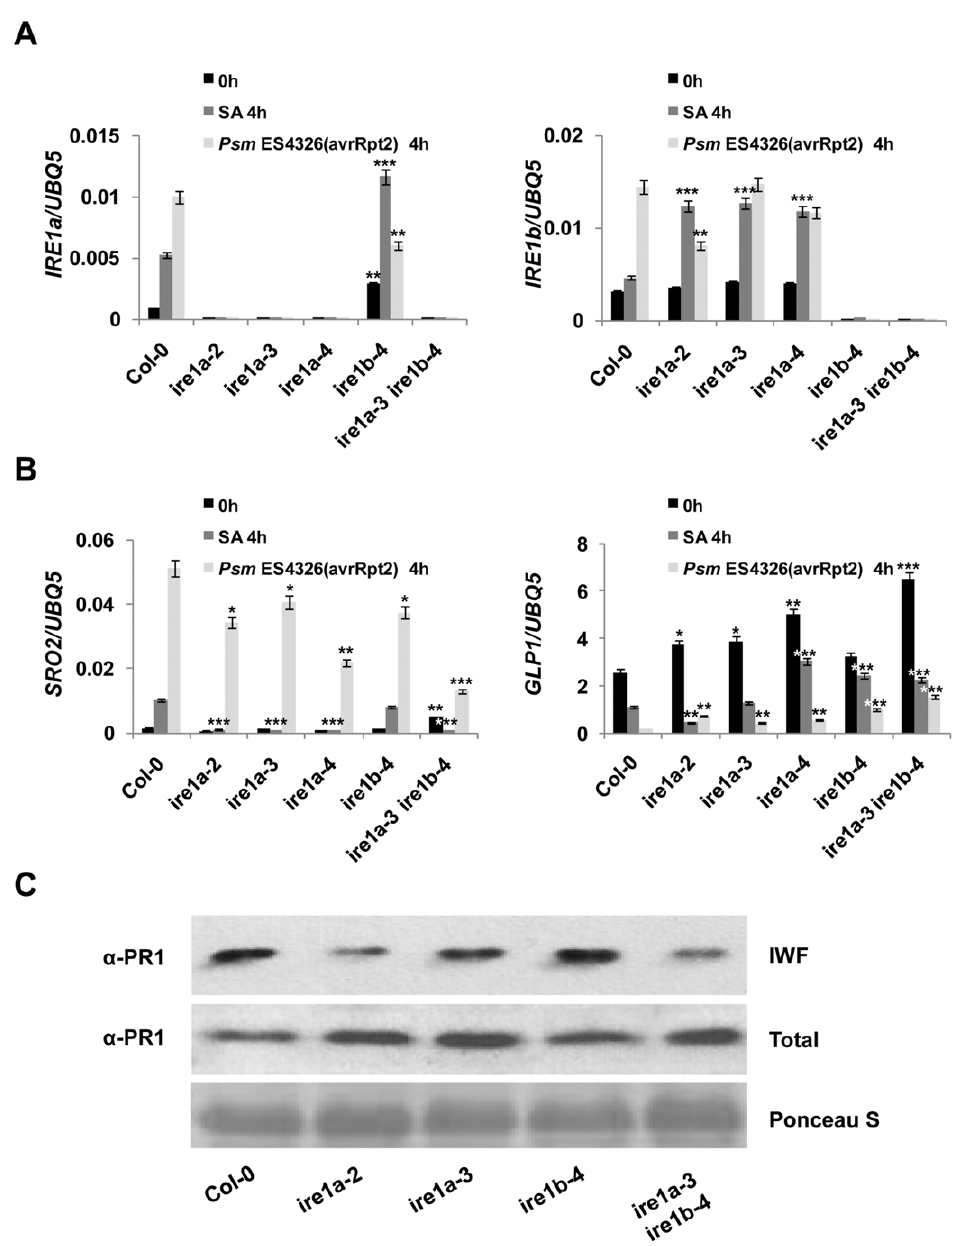
Figure 2. UPR-responsive genes and PR1 secretion is affected in ire1 mutants. A, The expression of IRE1a and IRE1b and B, SRO2 and GLP1were quantified in response to SA and Psm ES4326(avrRpt2) for 4 hours in the indicated genotypes using real-time RT-PCR. Increased expression of IRE1a, IRE1b, SRO2 and reduced transcript of GLP1 can be observed in the treated wild-type Col-0. Data represent the mean and SE of three technical replicates per treatment. Statistical analysis was performed using Student’s t -test, *, p , 0.05, **, p , 0.01, ***, p # 0.001. Experiments with at least two independent biological replications demonstrate similar results. C, PR1 protein accumulation in the ire1 mutants was compared with wild- type. Intercellular wash fluid (IWF) was collected from 20 leaves derived from 10 plants per indicated genotype treated with SA for 16 hours. Total protein was extracted from five leaves derived from three plants per indicated genotype treated with SA for 16 hours. Accumulation of PR1 was detected by Western blotting with anti-PR1 antibody in IWF and total leaf extract from the indicated genotypes. Ponceau S stain verifies equal loading. Experiments were repeated at least four times with similar results.